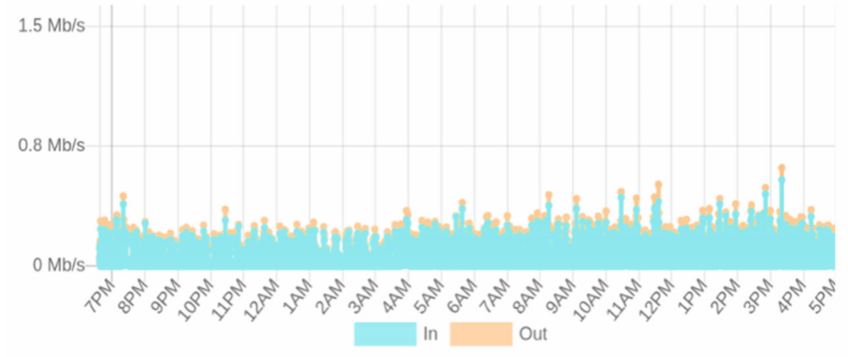
Figure 9. Network bandwidth utilization of the IPFS storage